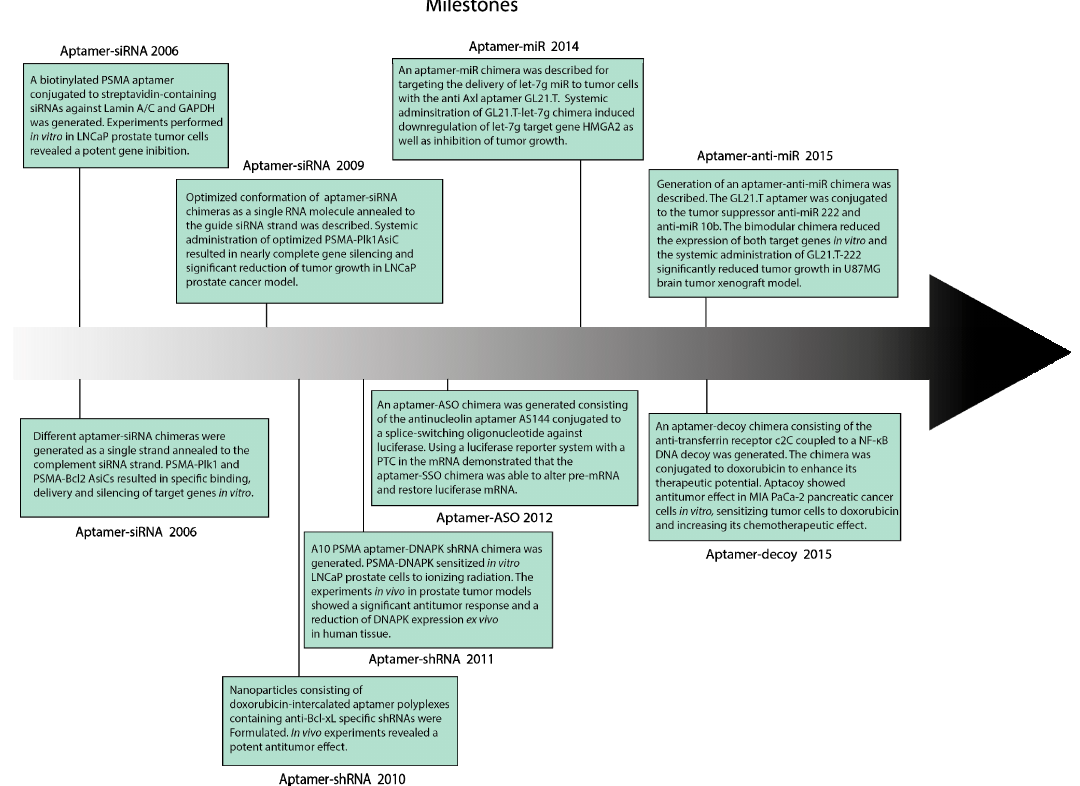
Figure 2. Milestones of each type of aptamer-iRNA chimeras for cancer treatment. PTC = premature stop codon; SSO = splice-switching oligonucleotide.